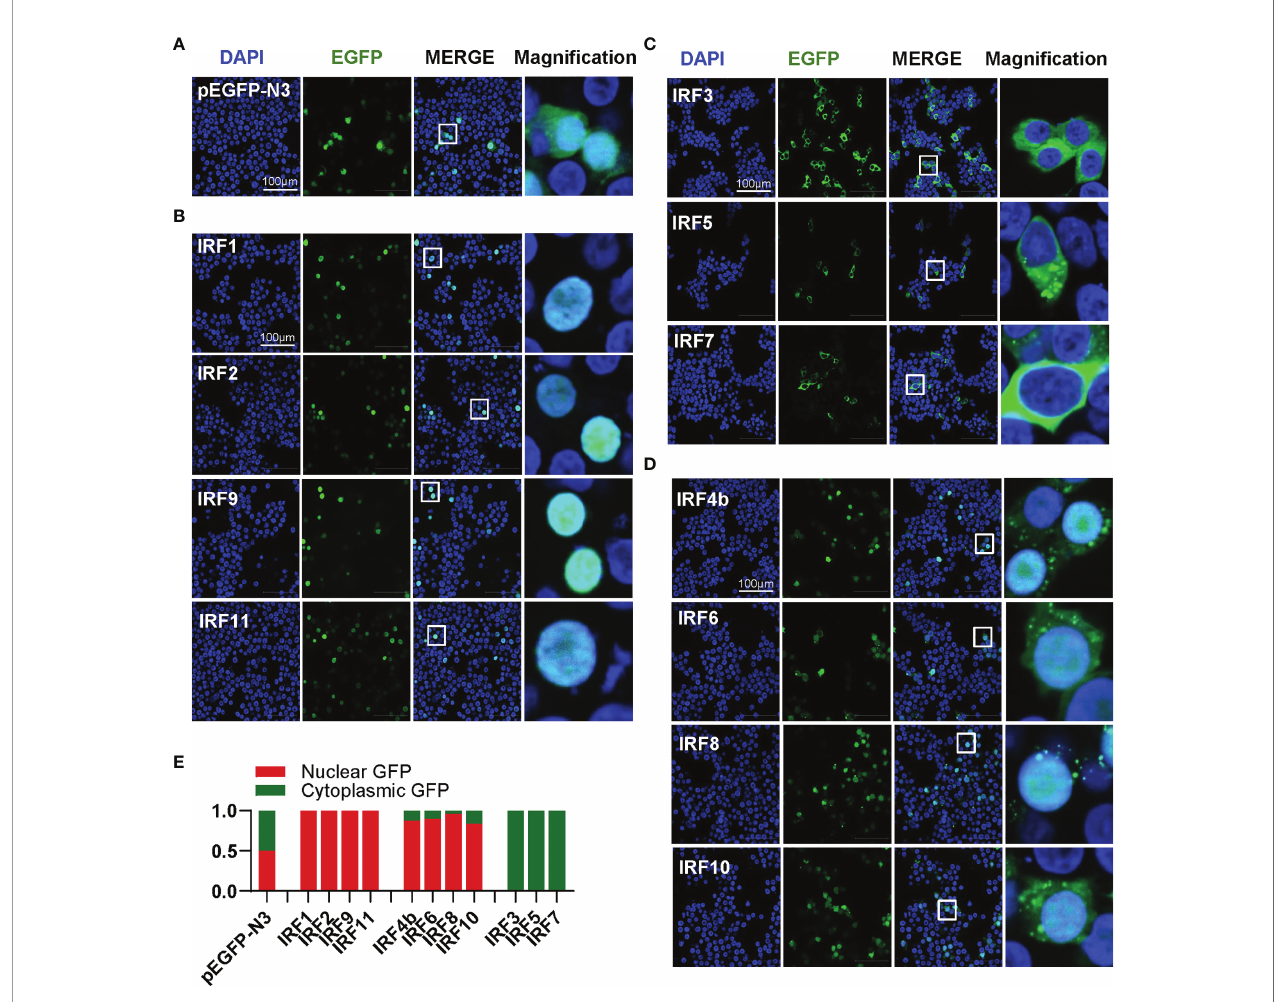
FIGURE 4 | Zebra fi sh IRF family members show three patterns of constitutively subcellular localization. (A – D) Confocal microscopy illuminates the subcellular localization of zebra fi sh IRF proteins. HEK293T cells seeded on microscope slide cover glasses overnight in six-well plates were transiently transfected with pEGFP- N3 as control (A) , or with each of GFP-fused IRF1/2/9/11 constructs (B) , or with each of GFP-fused IRF3/5/7 constructs (C) , or with each of GFP-fused IRF4b/6/8/ 10 (2 m g each). At 24 h post transfection, cells were fi xed and examined using a confocal microscopy. DAPI staining showed the nuclei. The last column showed magni fi cation view of the area highlighted in the box. (E) The intensities of nucleus/cytoplasm GFP were quantitated by the ImageJ processing program followed by normalization to that of pEGFP-N3, which was set to